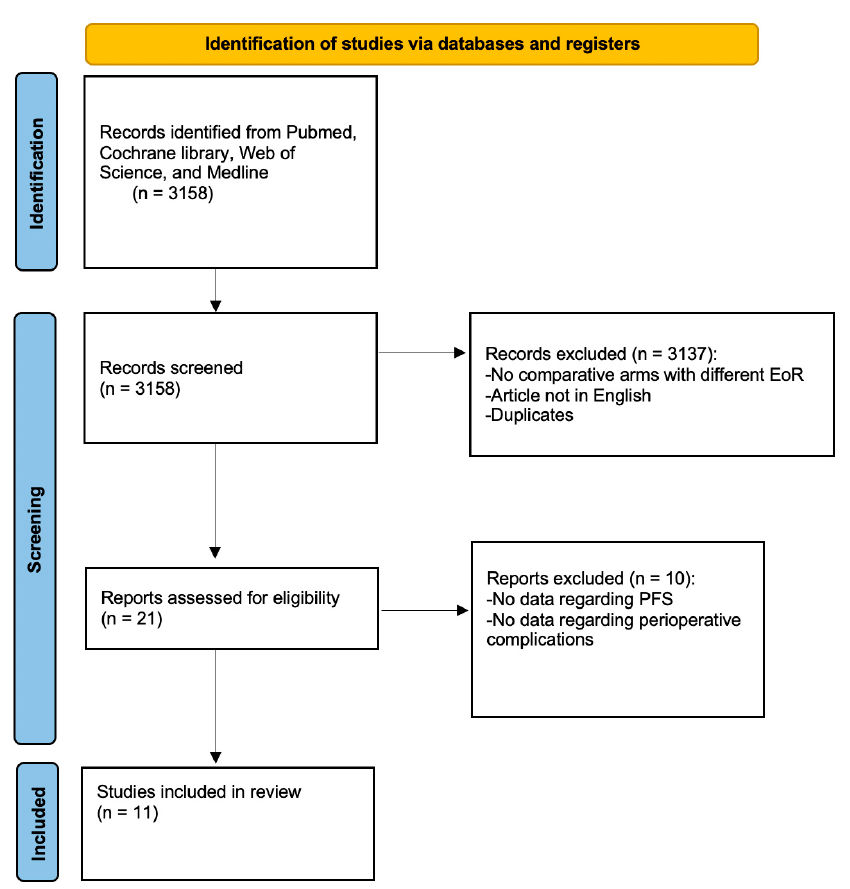
Figure 1. PRISMA flow chart illustrating the study selection.